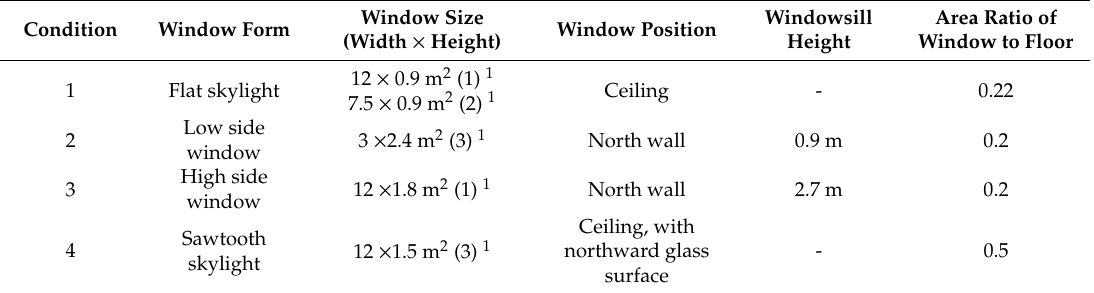
Table 1. Daylighting opening parameters of the hanging display under various window conditions.